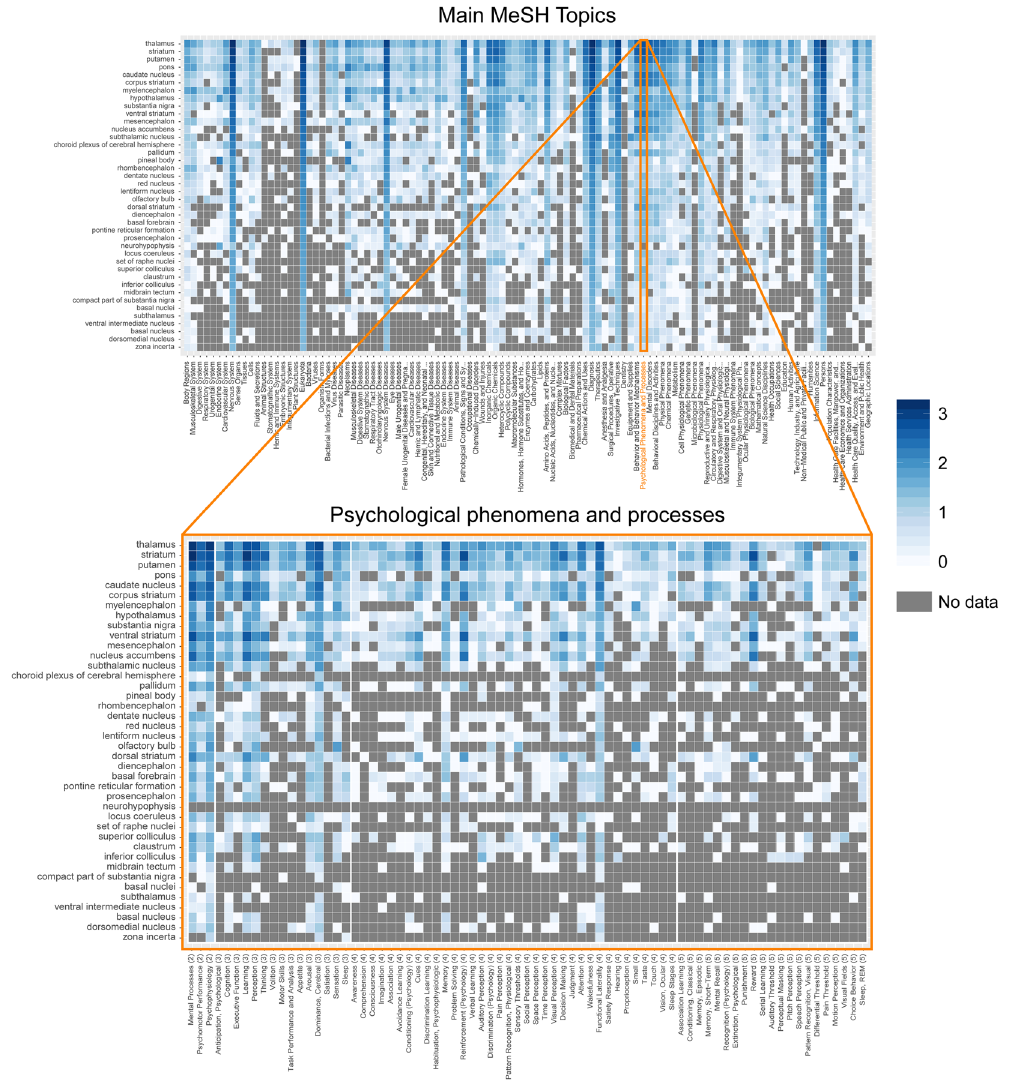
Figure 3. Structure-function mapping of the human subcortex. MeSH topics (x-axis) are shown for the subcortical structures with the highest number of unique publications (y-axis). Color shading indicates the number of publications for each structure-function pair. Top panel: The top main MeSH topics are displayed including the main Psychological phenomena and processes topic. Bottom panel: The top cognitive subtopics of the Psychological phenomena and processes branch. For visualization purposes only, we selected the Psychological phenomena and processes topics that had at least 13 publications associated with them. Note that this number was arbitrarily chosen to ensure manageable figure dimensions. The data and code to generate the figure without this filter can be found on osf.io/nf482. Values are cumulative according to the hierarchical structure of the MeSH ontology (different levels of the ontology are indicated by wider vertical spacing). Note that a similar figure is not possible for the topic model as the hierarchical topic structure is